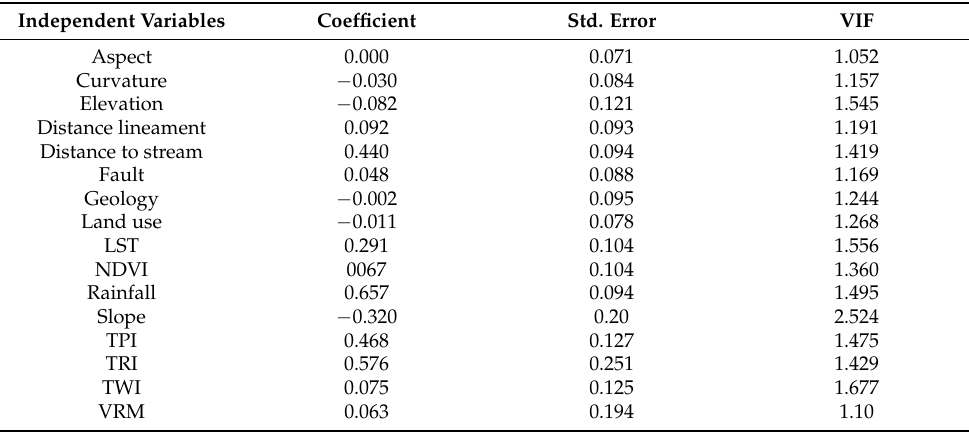
Table 2. Multicollinearity analysis among